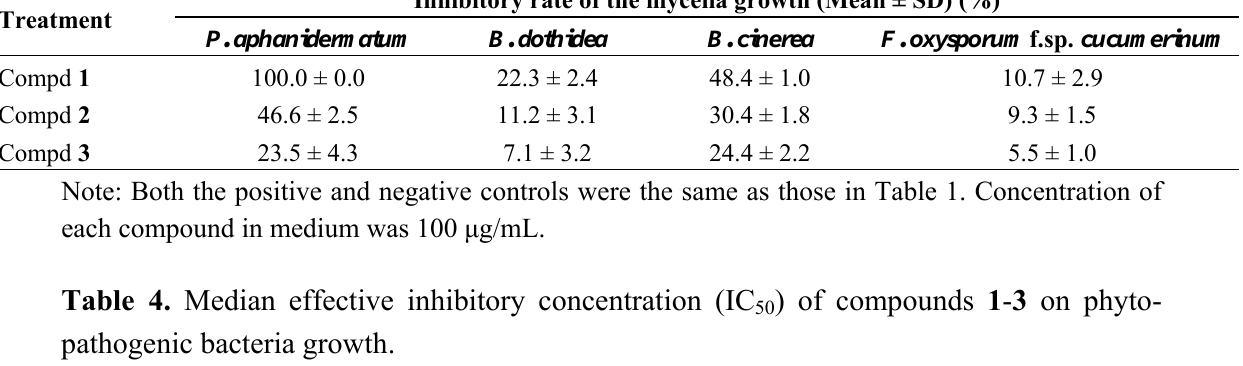
) of compounds 1 - 3 on phyto- 50